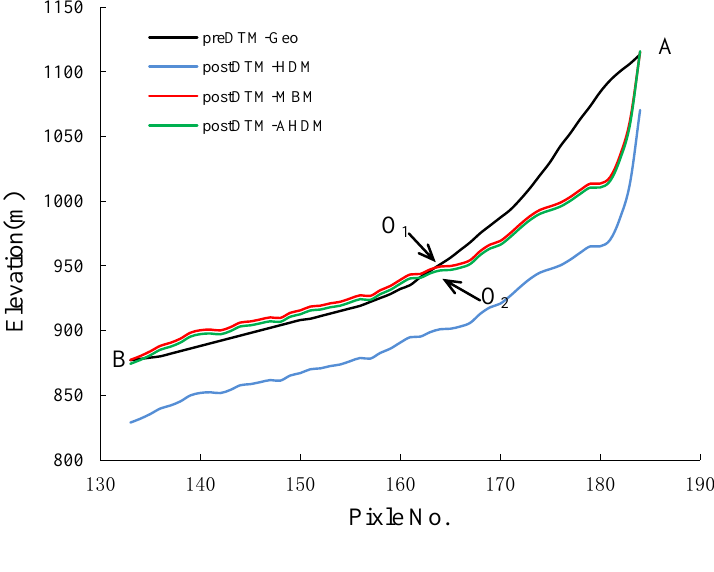
Figure 9. DTM profile lines corresponding to the pink dotted line in Figure 5. The black line is the pre-landslide DTM profile. The blue line is the post-landslide DTM profile without height adaptor adjustment (HDM is applied). The green line and the red line are, respectively, the post-landslide DTM profile with the height adjusted using AHDM (meanID_all) and